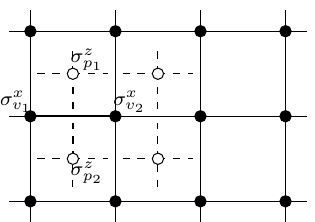
Figure 2 . The EM duality between the Ising model on the lattice (with solid lines), and the dual model (with dashed lines) on dual lattice. The plaquettes p 1 , p 2 , . . . in the original lattices are identified as vertices on the dual lattice. The EM duality leads to the correspondence { σ x σ x σ x := σ x ⊗ σ x , which is an abbreviation of the full tensor product that involves the v 1 v 2 v 1 v 2 identity operators at all the other vertices of the lattice, on the link between v